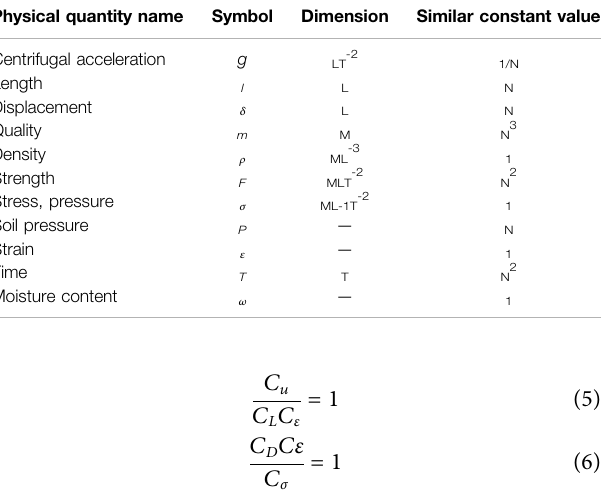
TABLE 1| Similarity constantsofcommonly usedphysicalquantitiesincentrifugal test (scale 1: N , C = prototype parameter/model parameter).